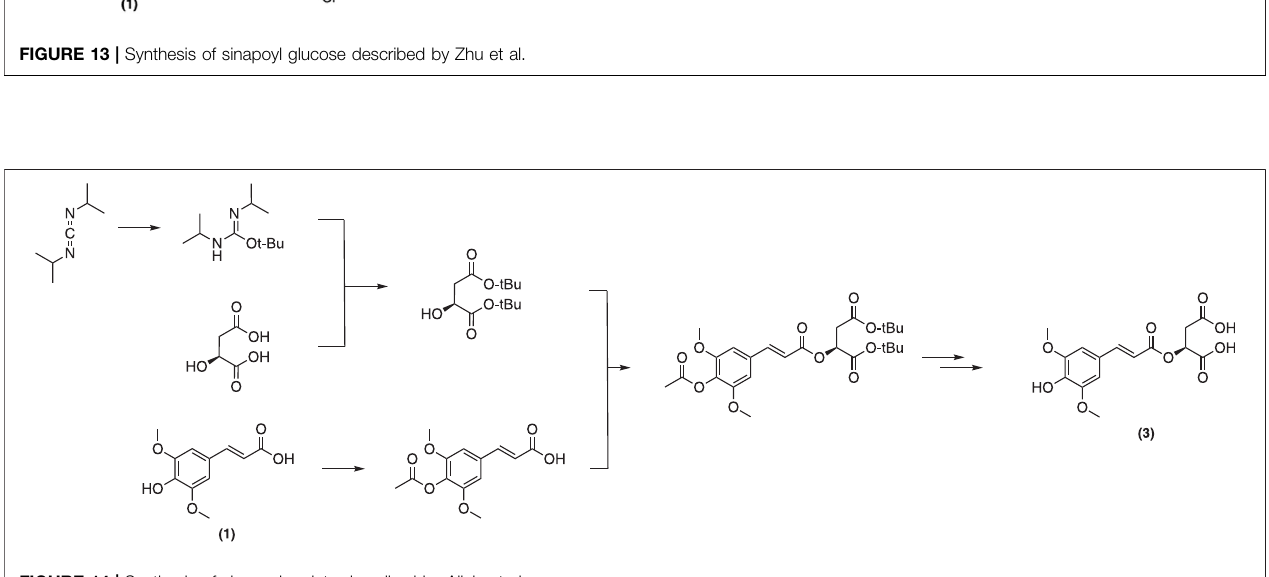
FIGURE 14 | Synthesis of sinapoyl malate described by Allais et al.